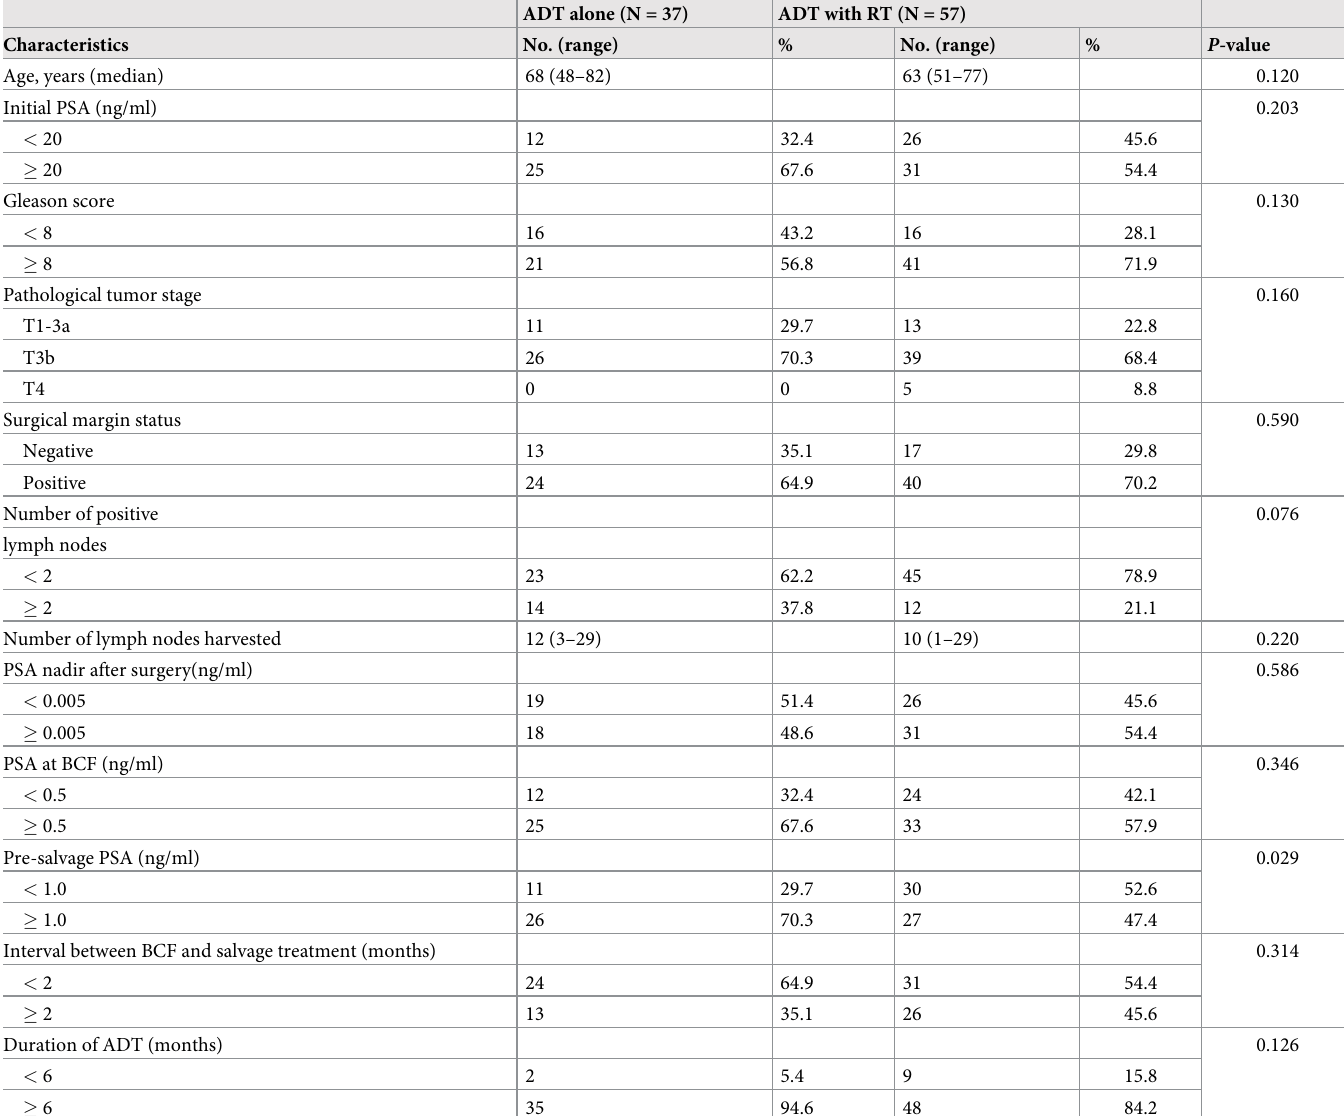
Table 1. Clinicopathological characteristics of the salvage treatment